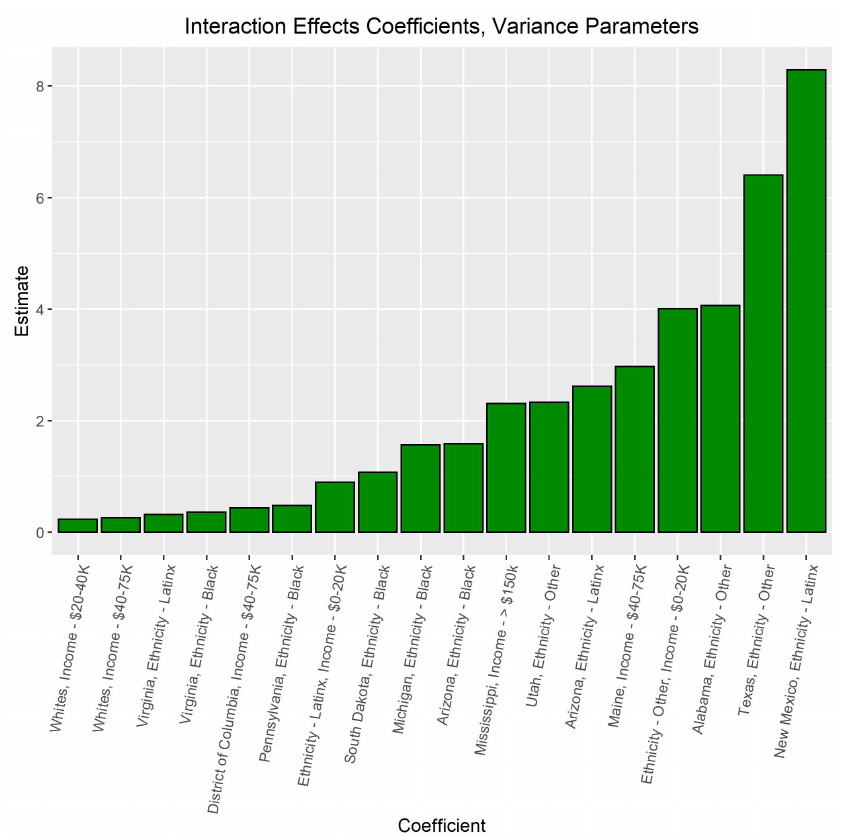
Figure 5. Selected Variance Parameters,